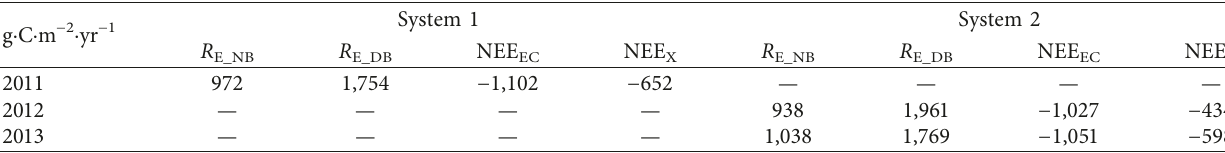
Table 3: Yearly ecosystem respiration ( R E ) from the nighttime (gap-filling tool) and daytime (Equation (3)) partitioning models; net ecosystem exchange defined as NEE EC after QA/QC, gap filling and u ∗ filtering; net ecosystem exchange including NEE DB for mountain breeze (NEE X based on equation (4)).